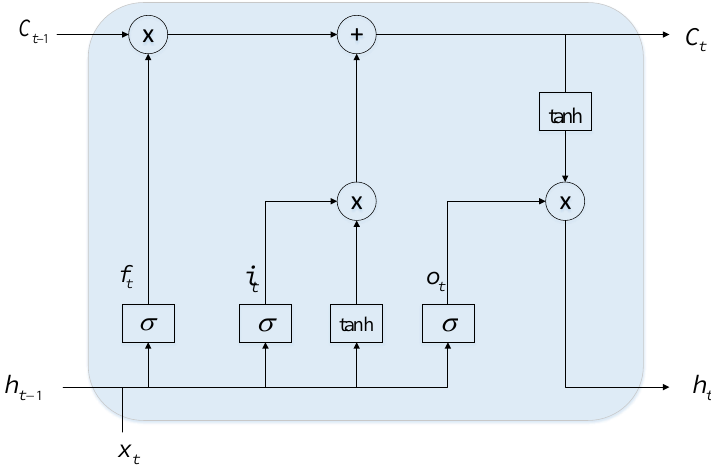
Figure 4. Structure of the LSTM network.